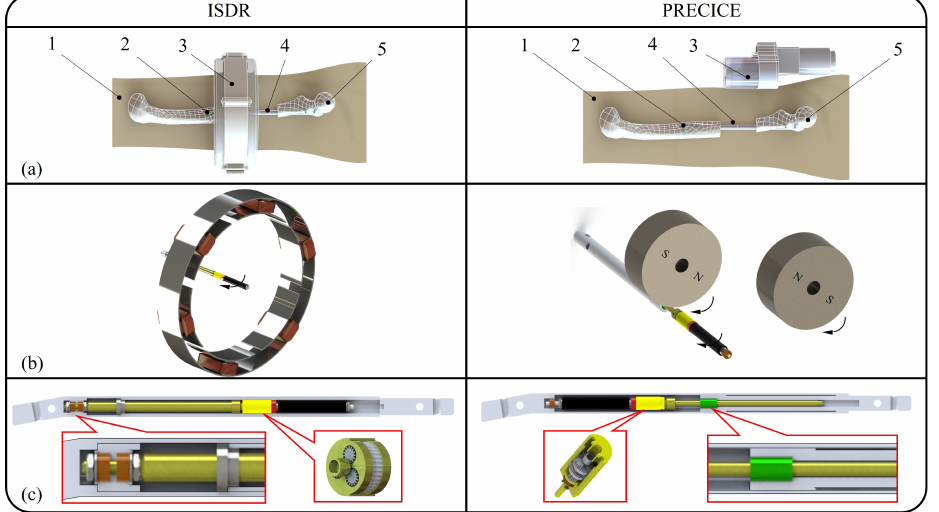
Figure 2. The comparison figure between ISDR and PRECICE. ( a ) The schematics of intramedullary lengthening nail system between ISDR and PRECICE. 1—thigh, 2—bone screws, 3—internal magnet driver, 4—implantable lengthening nail, 5—femur; ( b ) the schematics of driving method between ISDR and PRECICE; ( c ) the schematics of intramedullary lengthening nail between ISDR and